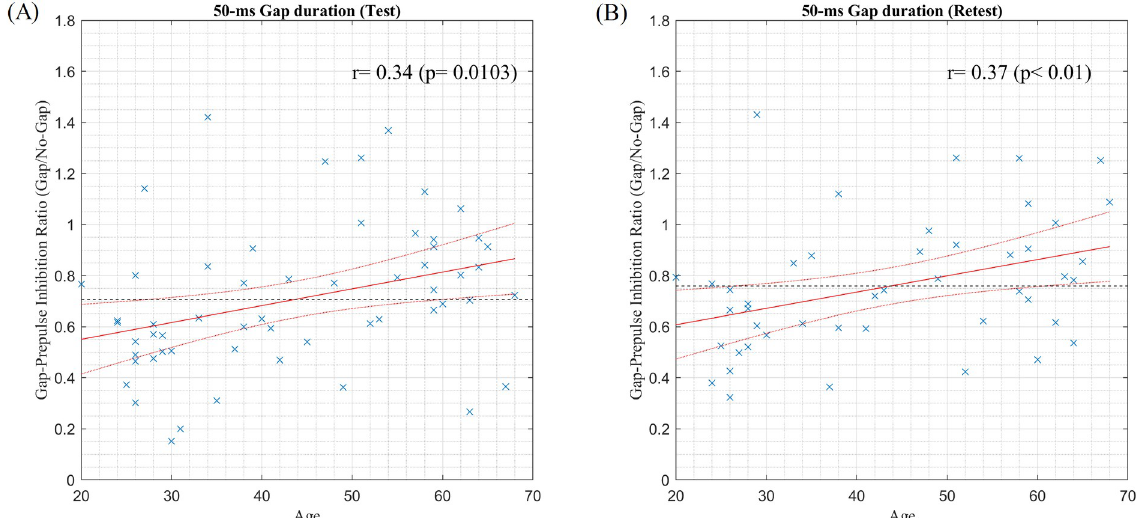
Fig 4. Scatter plots of age versus Gap/No-gap ratio with a 50-ms gap duration in the test (A) and retest (B) sessions. The red solid and dotted lines indicate the fitting line and 95% confidence bounds, respectively, based on the linear regression analysis. The black dotted line indicates the average of all Gap/No-gap ratios.